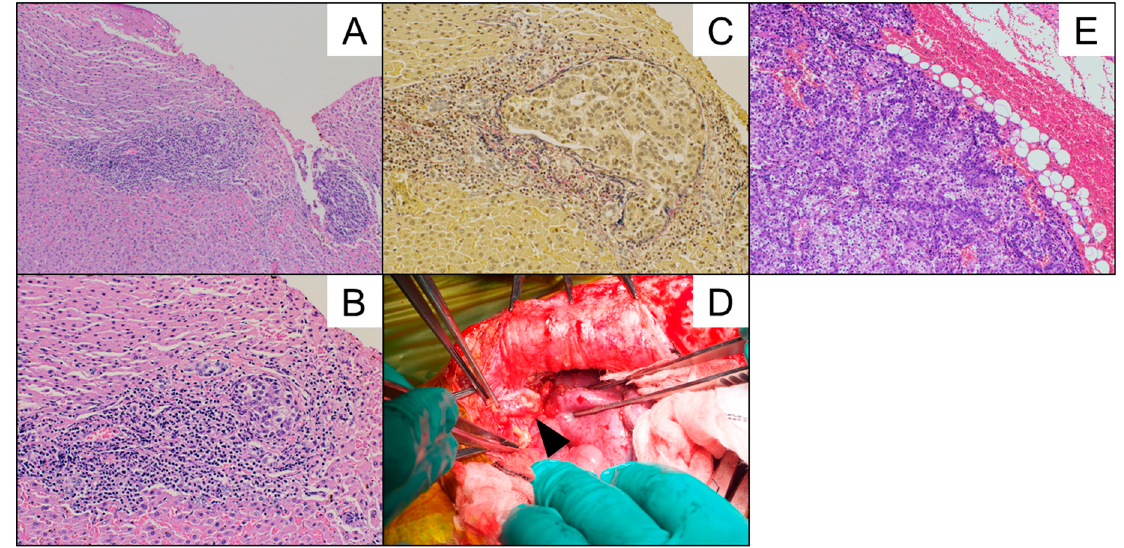
Figure 2. ( A , B , C ) The pathological findings of the metastatic nodule in the liver, which were compatible with wholly epithelial-type (fetal subtype) hepatoblastoma (HB) with vascular invasion. ( A , B ; H.E. stain, A ;100×, B ;200×, C ; Elastica van Gieson(EVG) stain, 200×). ( D ) The arrowhead represents the peritoneal nodule adjacent to the transplanted liver, which was noted in the first laparotomy after the first LDLTx procedure. ( E ) The pathological findings of the peritoneal nodule is shown in Figure (H.E. stain, 100×).